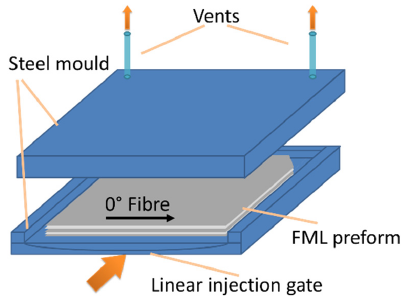
Figure 2. Steel mould with FML preform.